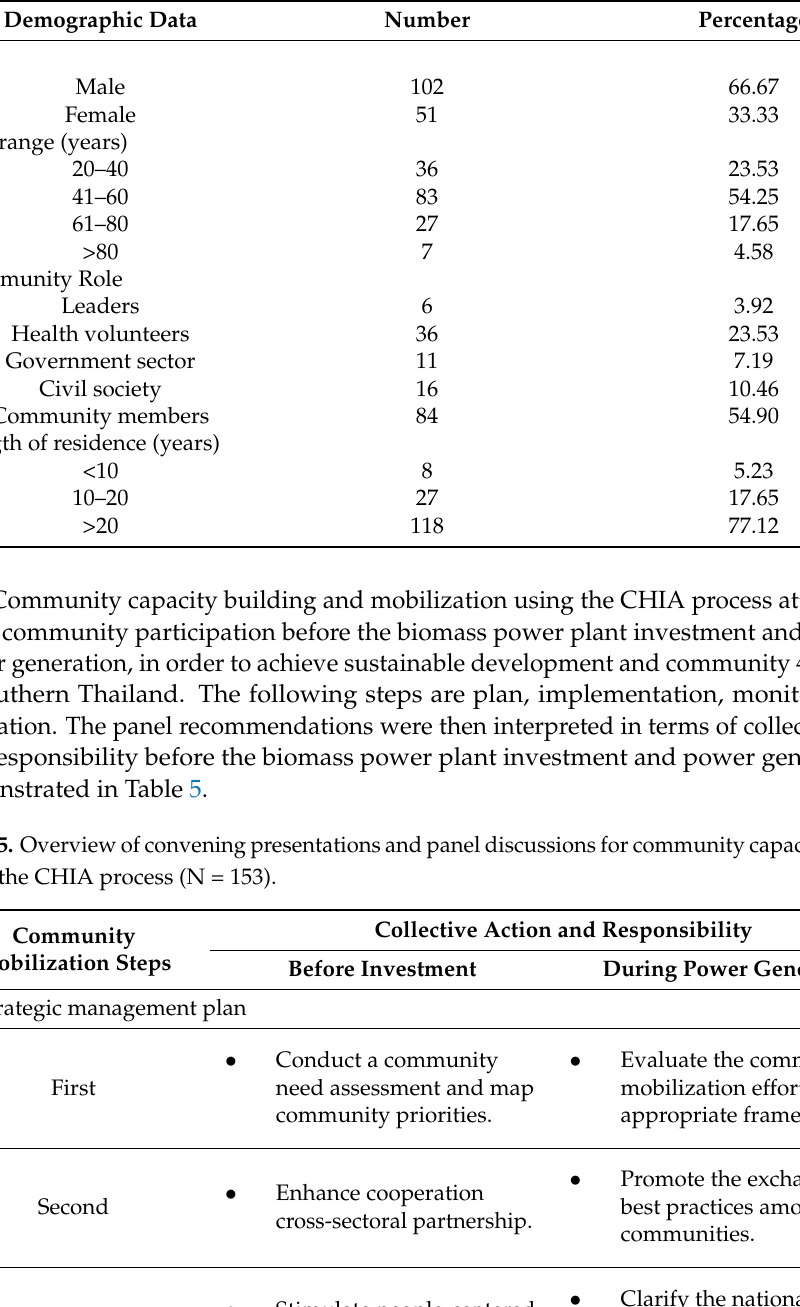
Table 4. Study participants in panel discussion (N = 153).